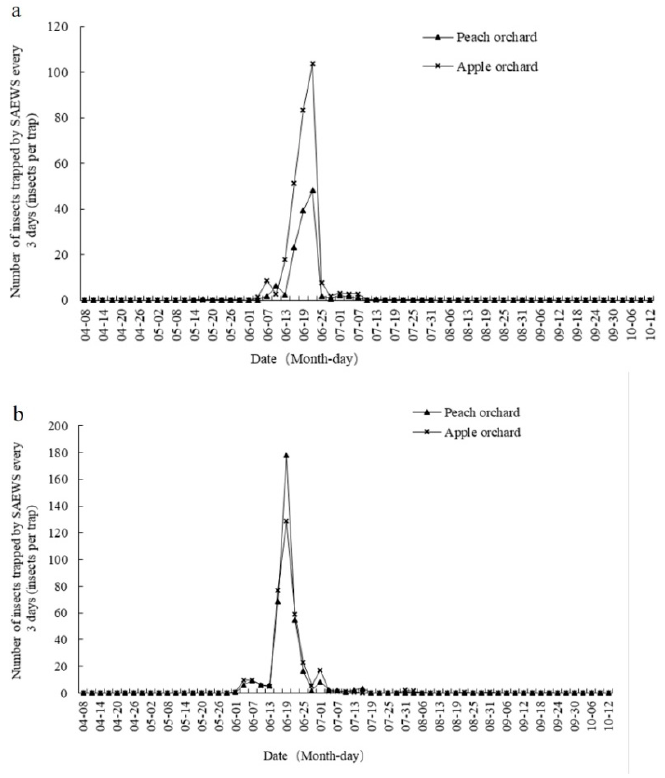
Figure 3. Dynamics of ( a ) Coccinellidae and ( b ) Chrysopidae trapped by SAEWM-baited traps in Tai’an, China, in 2016.